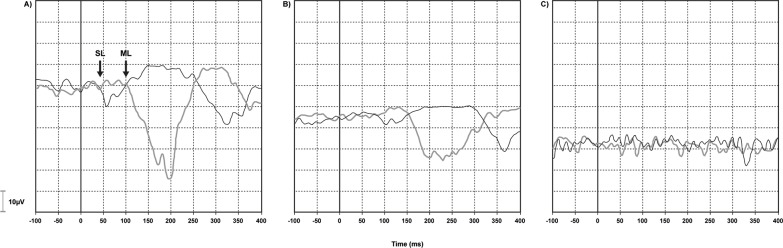
Normal, delayed, and abnormal response patterns in vestibular-evoked myogenic potential triggered by galvanic vestibular stimulation (galvanic-VEMP).(A) Normal electromyographic (EMG) response recorded from the gastrocnemius muscle. The black line indicates the trace with the cathode on the right and the anode on the left, whereas the gray line indicates the opposite stimulation polarity. SL (~50 ms) and ML (~100 ms). (B) Delayed EMG responses. SL ~80 ms and ML ~150 ms. (C) Absent EMG response, no SL and no ML.